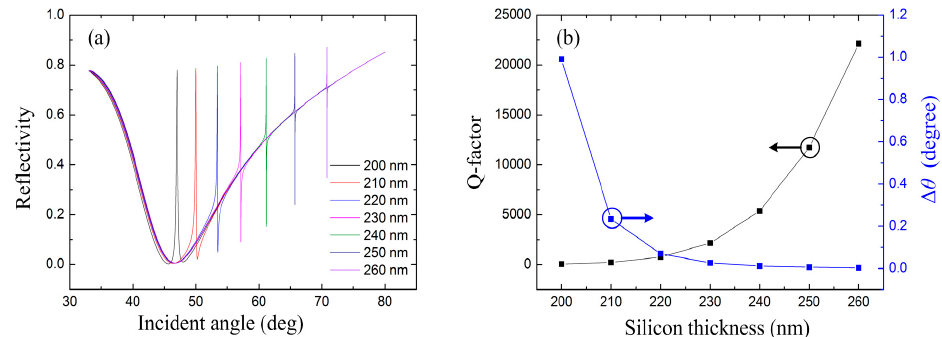
Figure 3. ( a ) ATR curves with different silicon thicknesses, and ( b ) Q ‐ factor and the Δ θ of FR with different silicon thicknesses. The ITO and MgF 2 thicknesses t 1 and t 2 are fixed to be 110 nm and 700 nm, respectively.